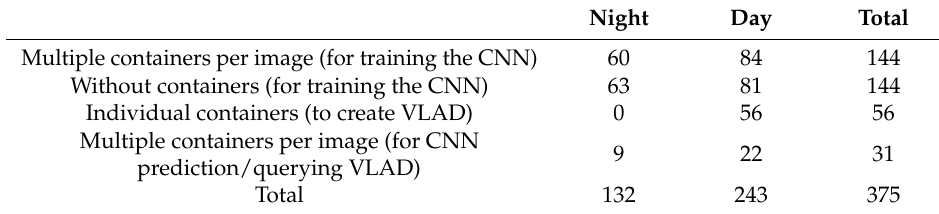
Table 1. The distribution of